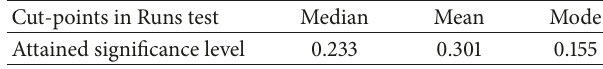
Table 1: The attained significance levels in Runs test.